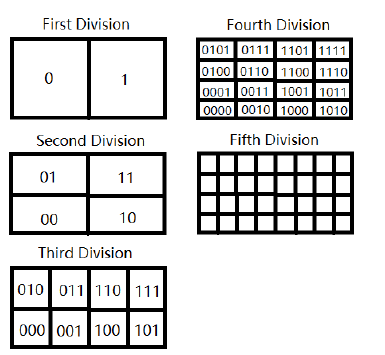
Figure 1. Procedure of Geohash code